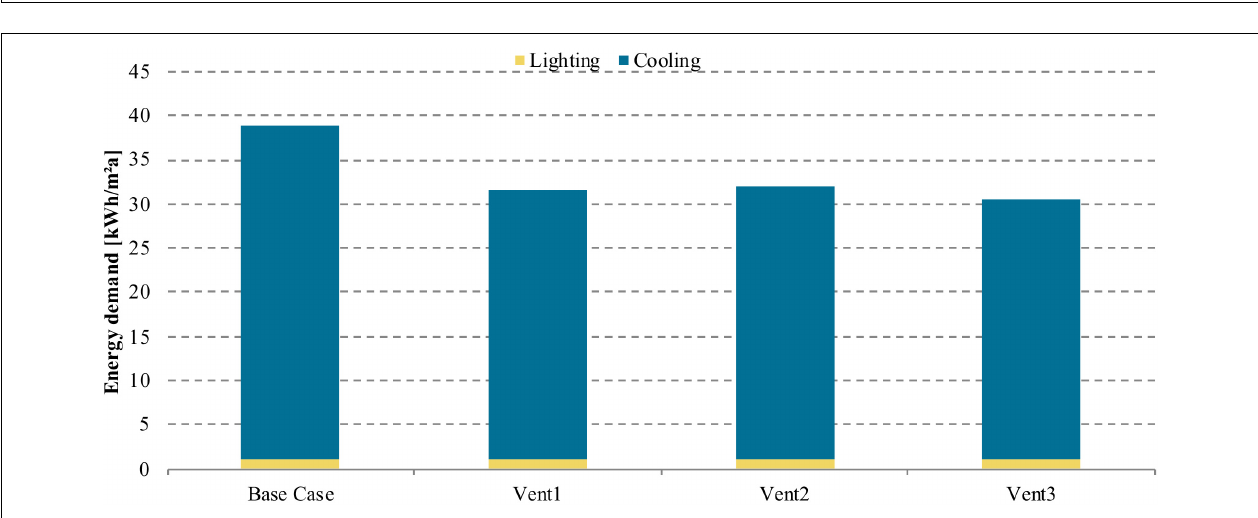
FIGURE 3 | Cooling and electricity for lighting demand due to the implementation of natural ventilation strategies in